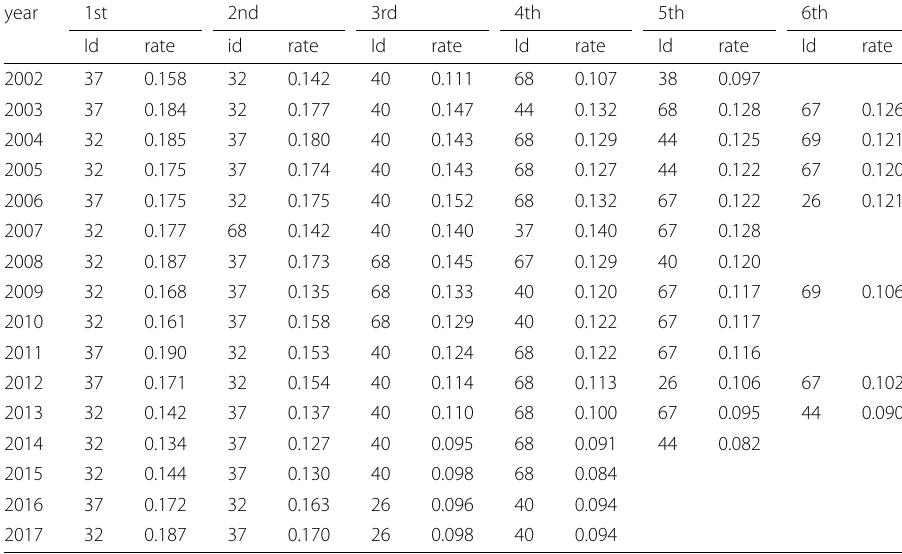
Table 1 For all years of data, we look at communities with crime rate that exceeds the average crime rate by at least 1 and 1/2 of the standard deviation for that